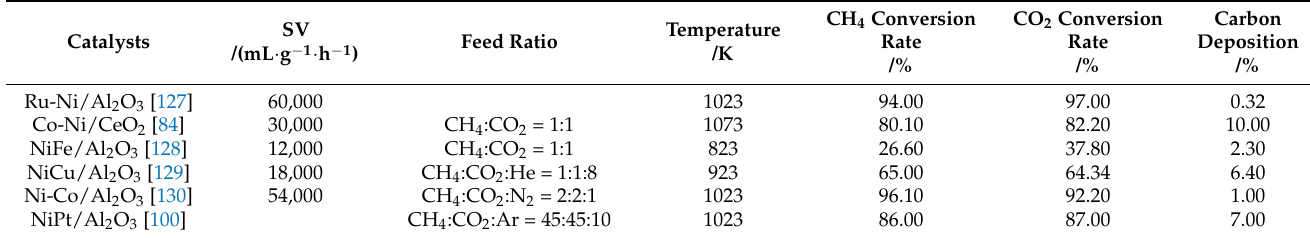
Table 2. Carbon deposition resistance of bimetallic catalysts in DRM.